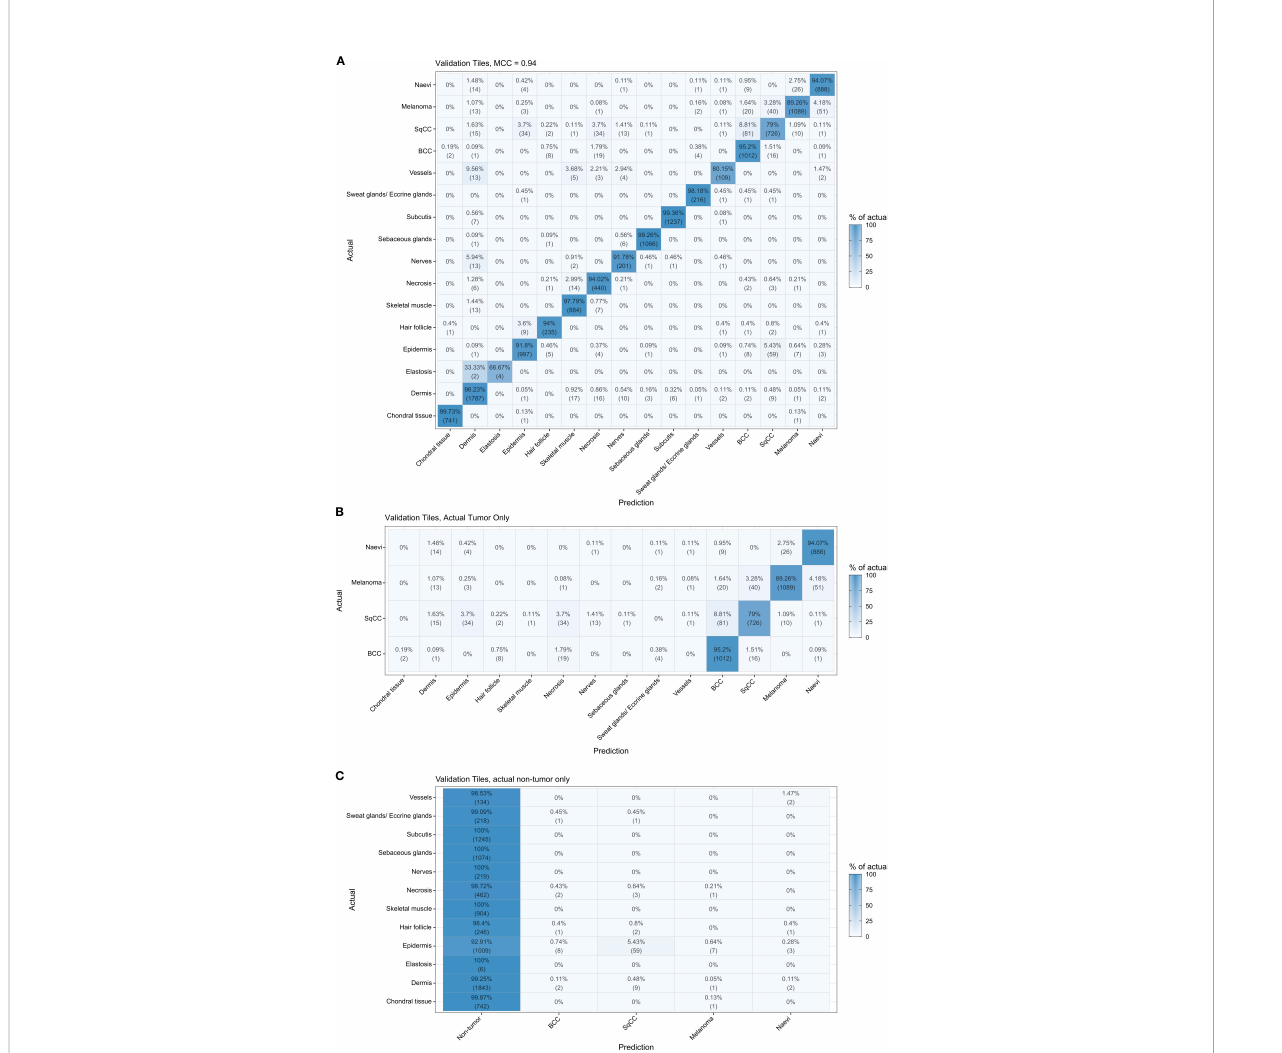
FIGURE 3 Confusion matrix of the validation set. High concordance between actual and predicted classes can be observed. The algorithm shows a higher rate of misclassi fi cation of elastosis and vessels with dermis, which can be explained since elastotic changes and vessels are commonly observed in the dermis (A) . In tumor categories (B) a higher rate of misclassi fi cations was observed for squamous cell carcinomas that were predicted as basal cell carcinoma. The misclassi fi cation of non-tumor categories as tumor was rare but observed with epidermis, misclassi fi ed as squamous cell carcinoma (C) . BCC, basal cell carcinoma; SqCC, squamous cell